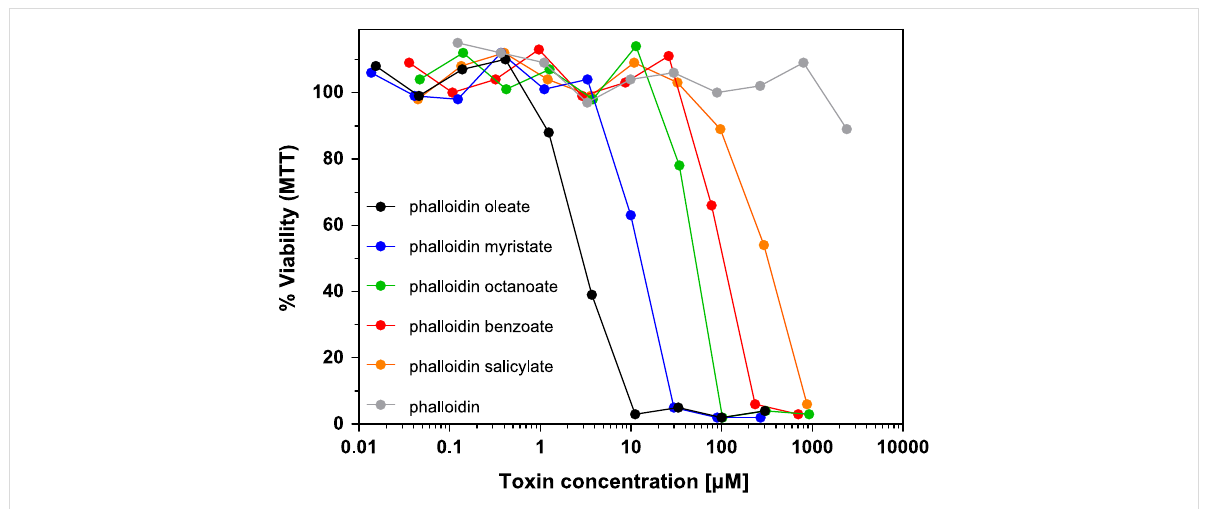
Figure 2: Cytotoxicity of phalloidin derivatives. NIH 3T3 mouse fibroblasts were incubated with various concentrations of phalloidin and phalloidin derivatives. Cell viability was determined after 72 h incubation time by MTT assay.